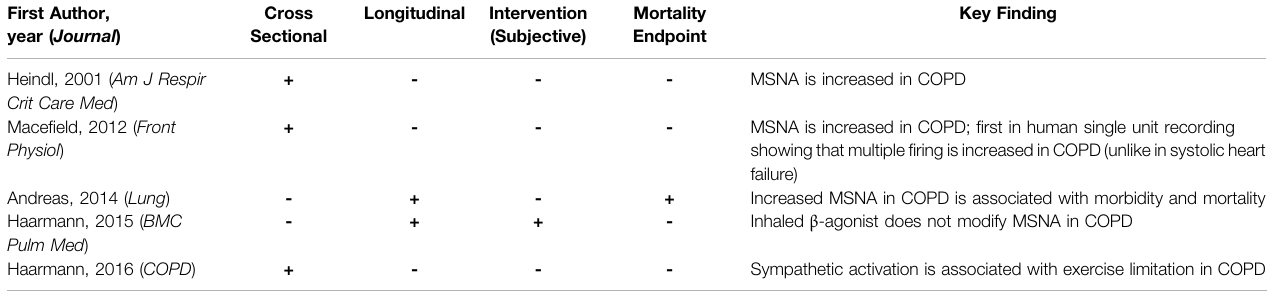
TABLE 1 | Summary of key studies invasively investigating sympathetic nerve activity (SNA) in chronic obstructive pulmonary disease